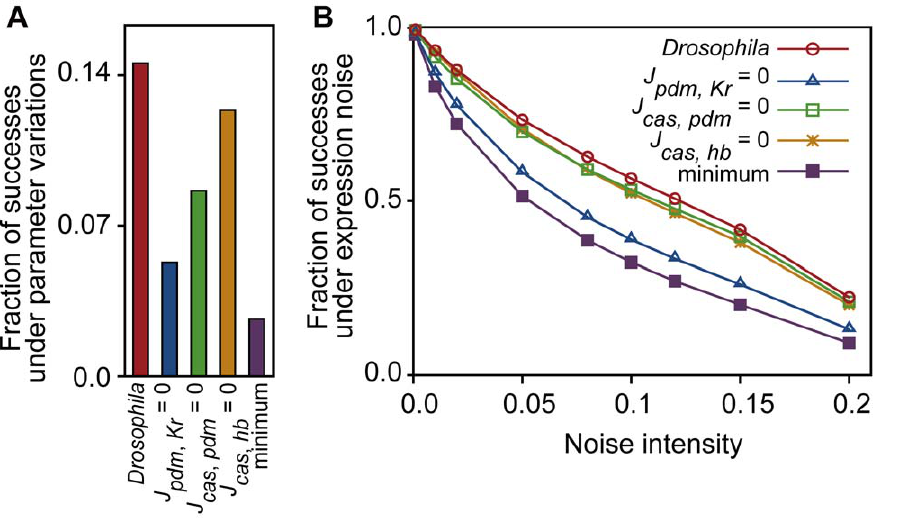
Figure 6. Contribution of the actual regulations to the robustness of the system. ( A ) The fraction of the trials that reproduce the experimental WT expression against parameter variations. The data of Figure 5A are replotted for the Drosophila network, the networks lacking an indicated regulation (one of the gray arrows in Fig. 3A) and the minimum network (black and brown arrows in Fig. 3A). ( B ) The fractions of the trials that reproduce the experimental profile under gene expression noise with various intensities. We used 5,000 different parameter sets with which the profile is reproduced in the absence of noise. The dynamics are checked for 50 trials for each parameter set.